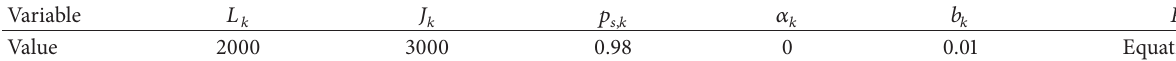
Table 1: The main parameters for implementing the adaptive PHD filtering.